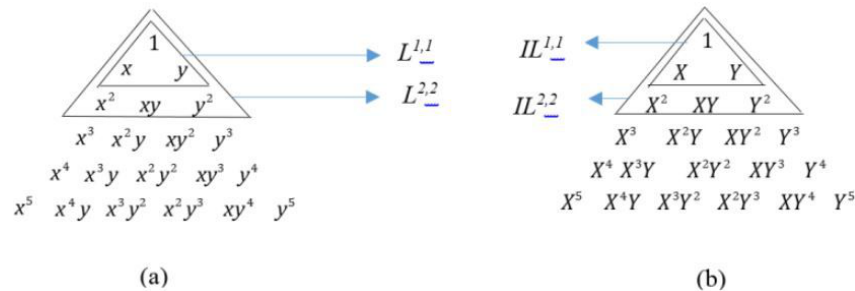
Figure 5: (a) Lagrange family; (b) Shifted-Lagrange family